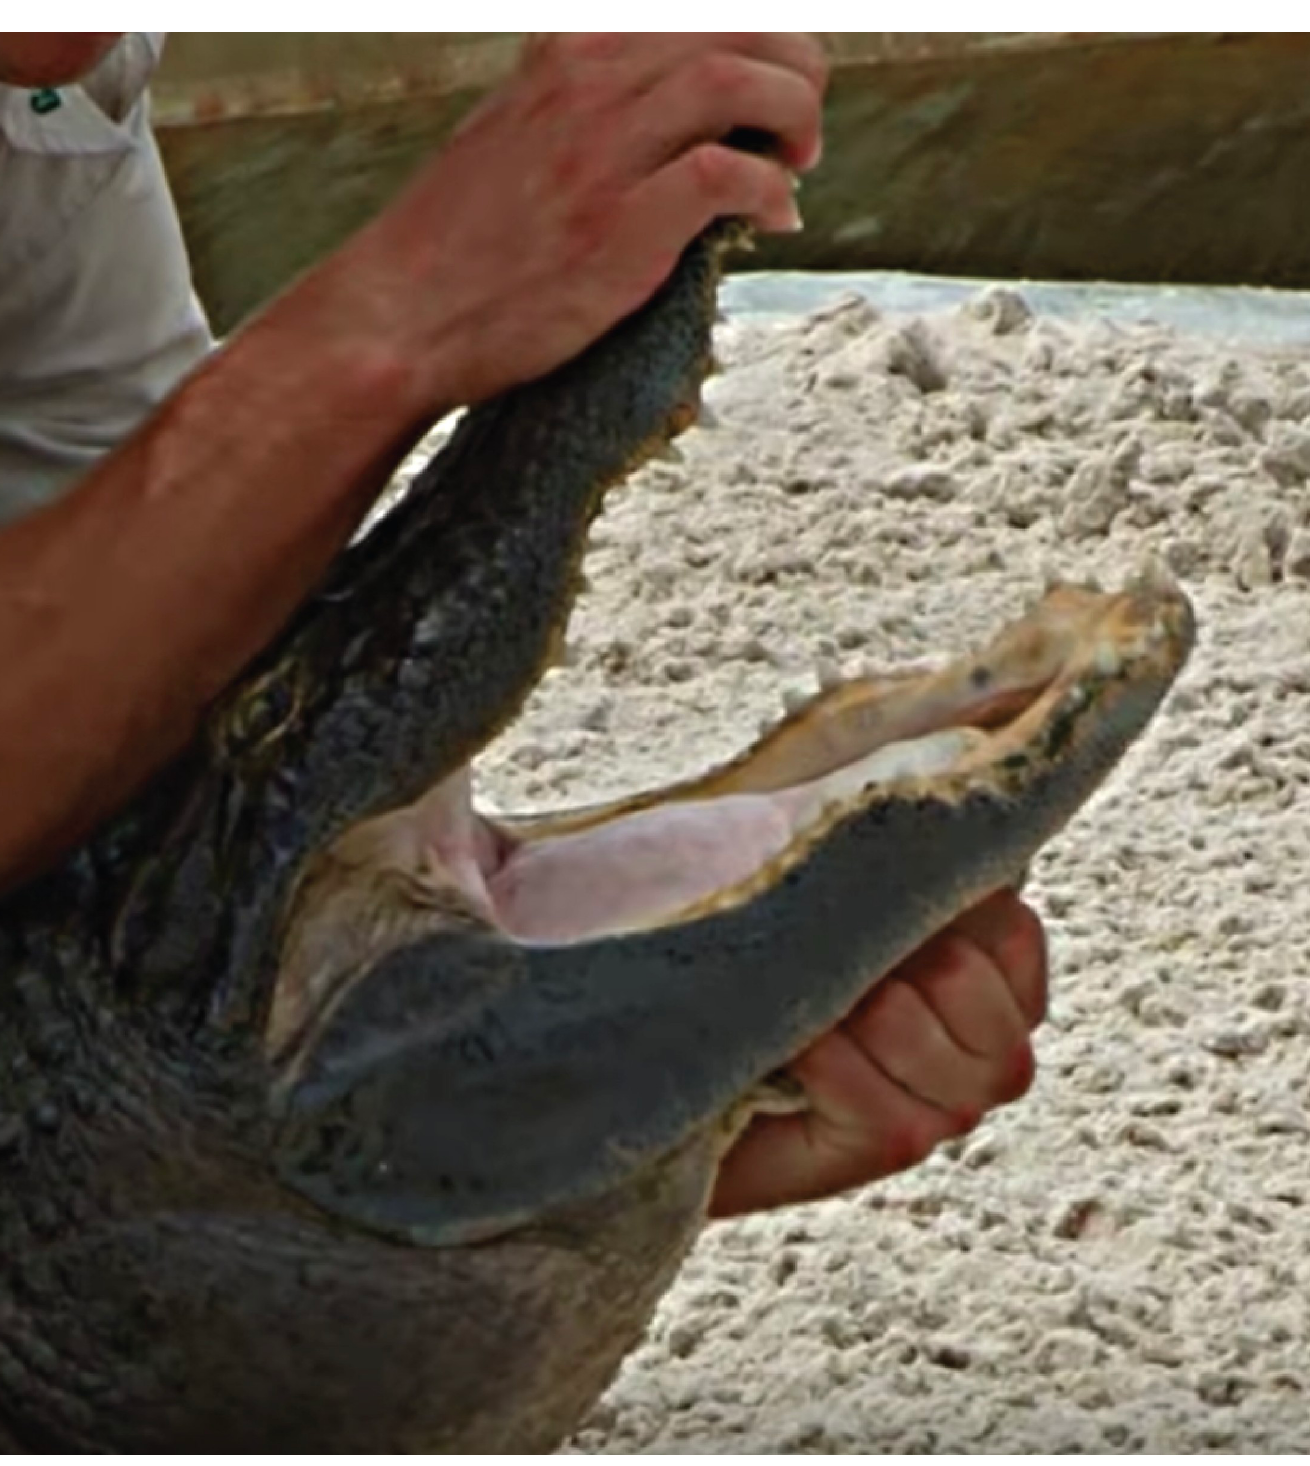
PLOS ONE | https://doi.org/10.1371/journal.pone.0242106 November13,